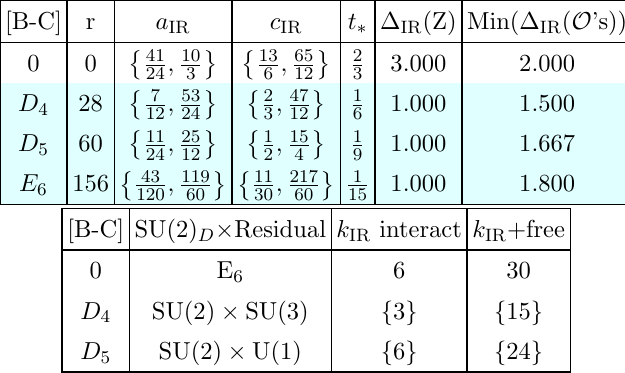
Table 14. Flipper (cid:12)eld deformations of the Minahan-Nemeschansky theory with E 6 (cid:13)avor, only rational values. The top table has the central charges a IR and c IR as well as scaling dimensions while the table below contains the information about the (cid:13)avor central charges. The cyan highlighted entries align with the H 0 , H 1 and H 2 Argyres-Douglas theories, as (cid:12)rst noted in [17, 18].